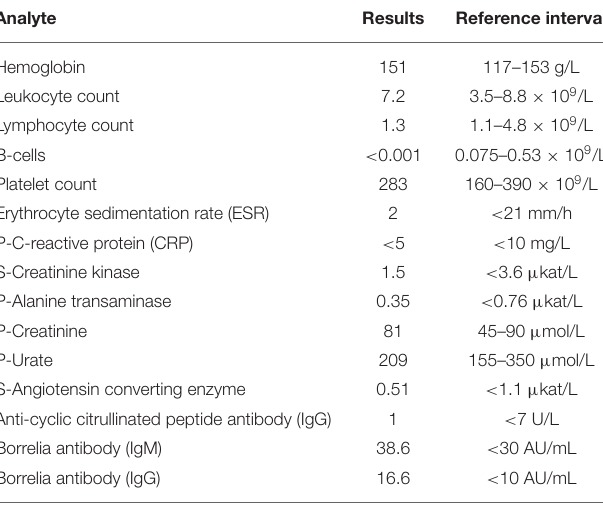
TABLE 1 | Laboratory findings in